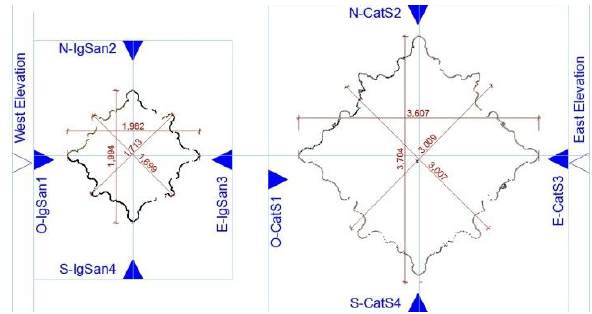
Figure 11. +1.80 m sections of the pillars: the Church of Santiago (left) and the Cathedral of Seville (right)